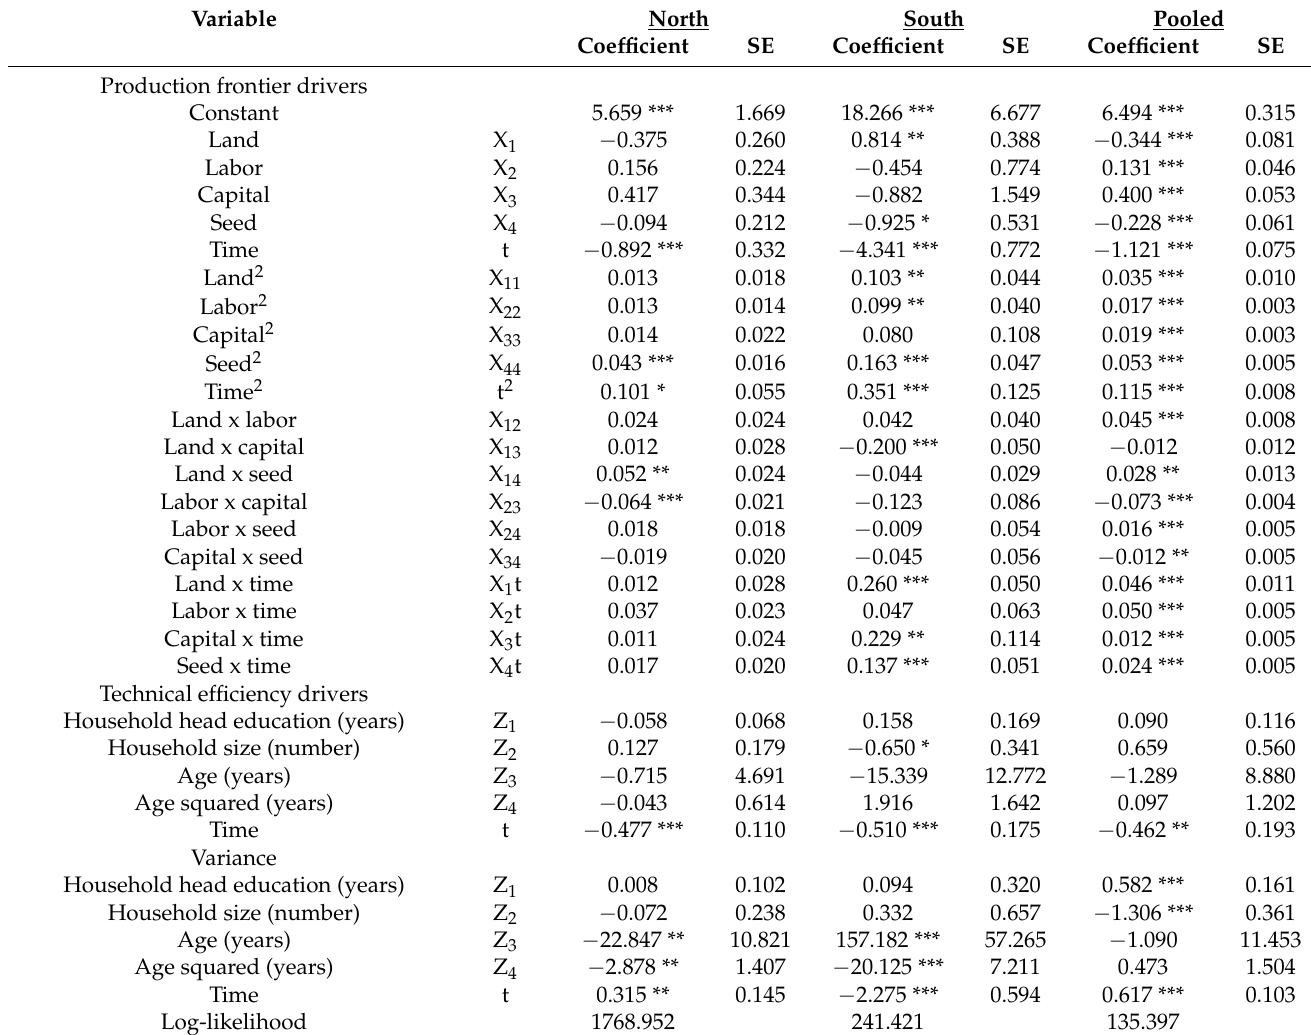
Table 3. Parameter estimates of group-specific and metafrontier production